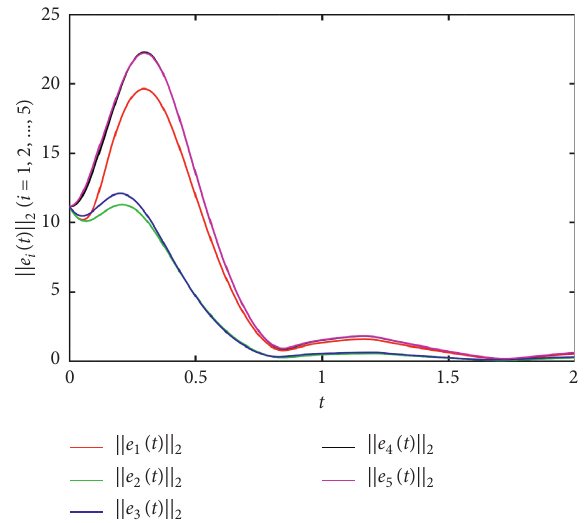
Figure 5: The changes of ‖ e